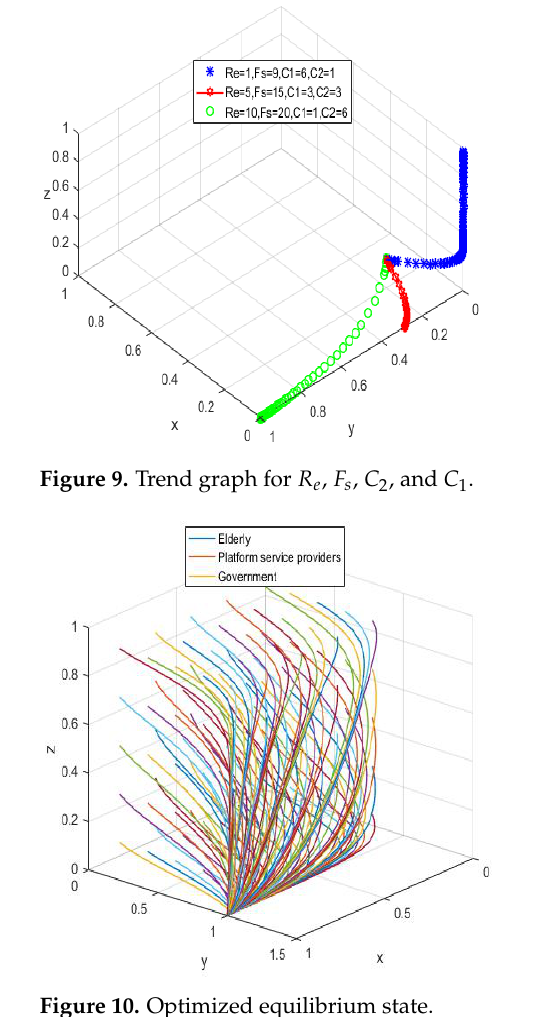
Figure 10. Optimized equilibrium state.